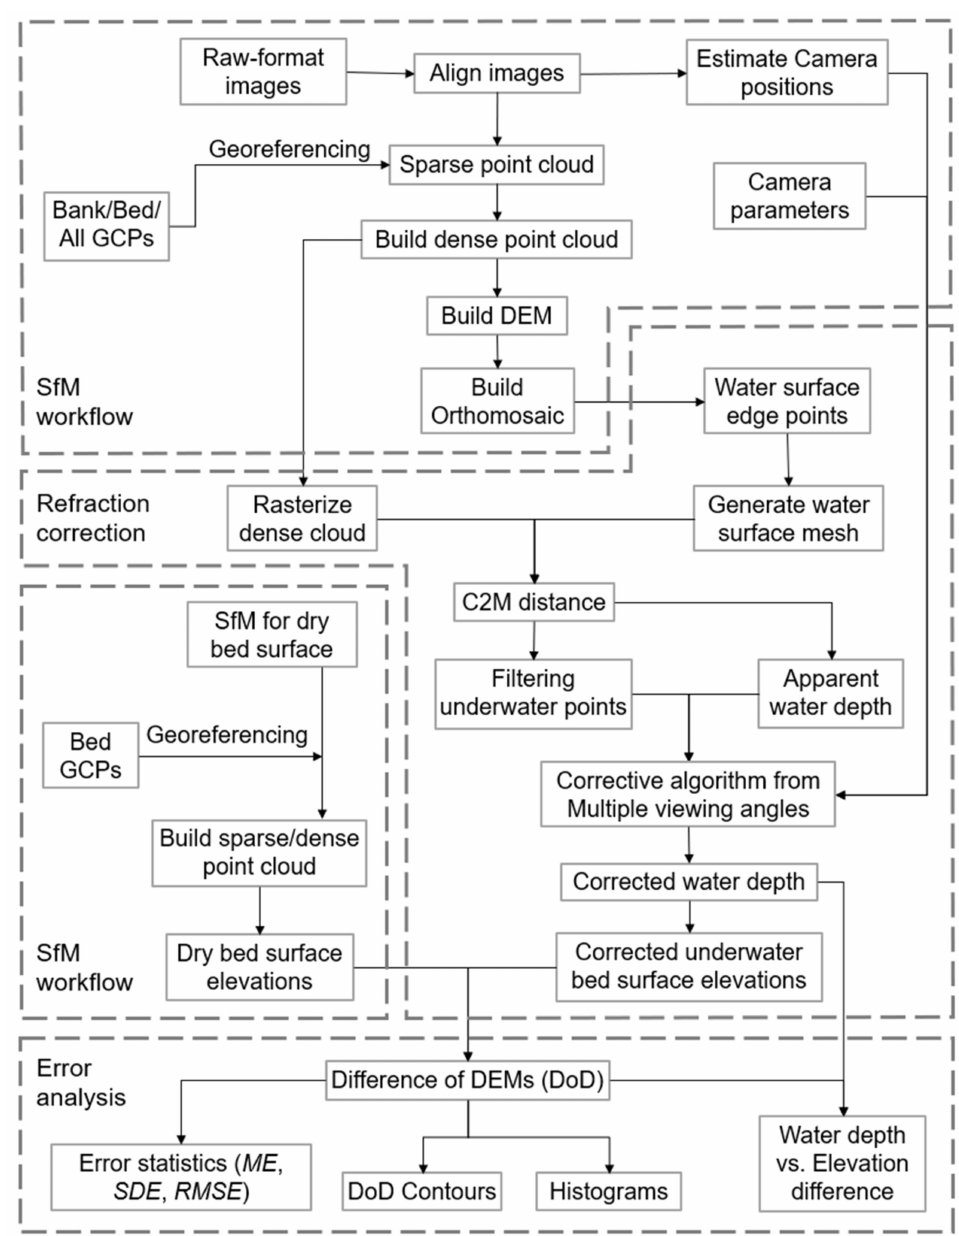
Figure 3. Schematic workflow of data processing in this